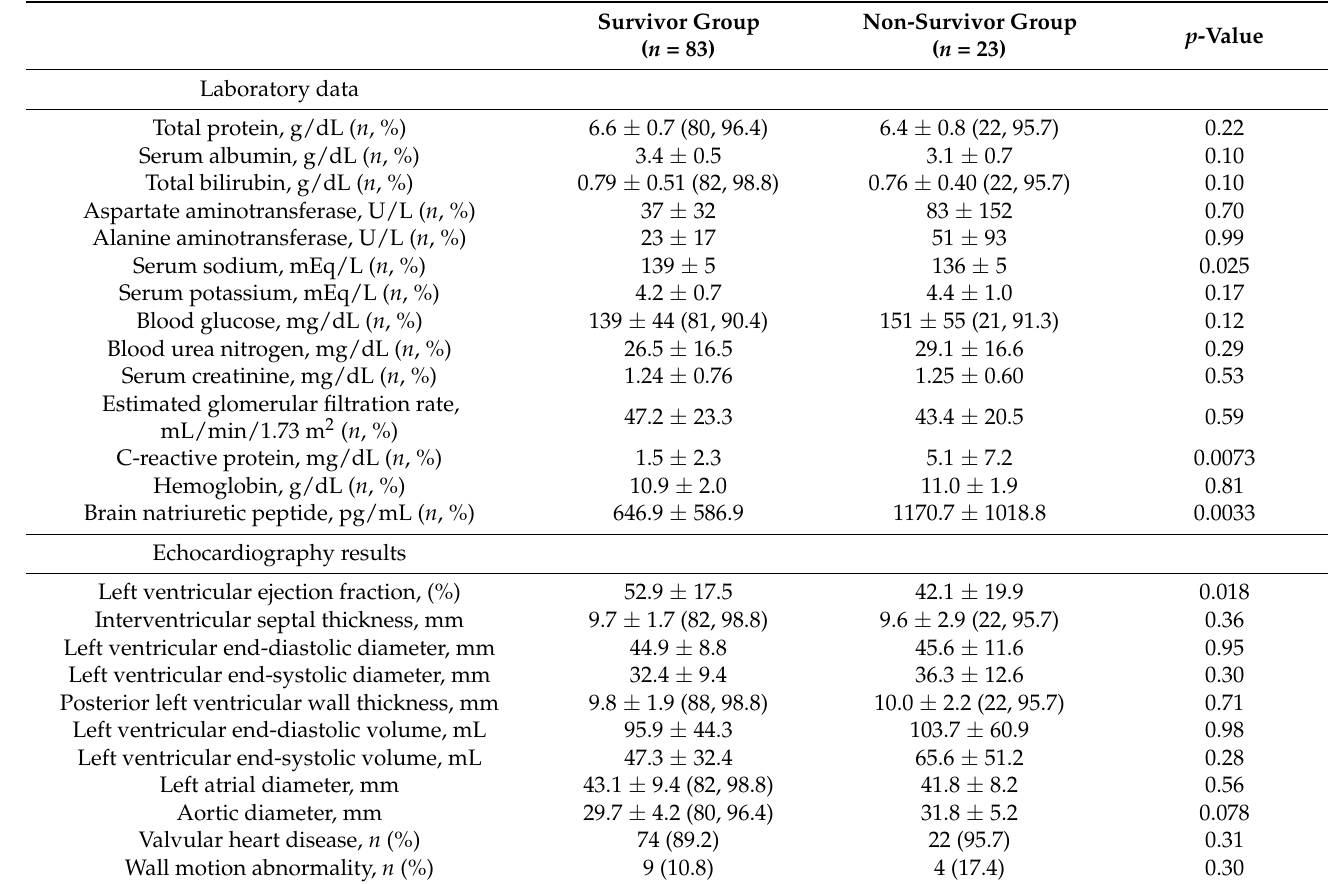
Table 2. The comparison of baseline laboratory data and echocardiographic parameters between the survivor and non- survivor